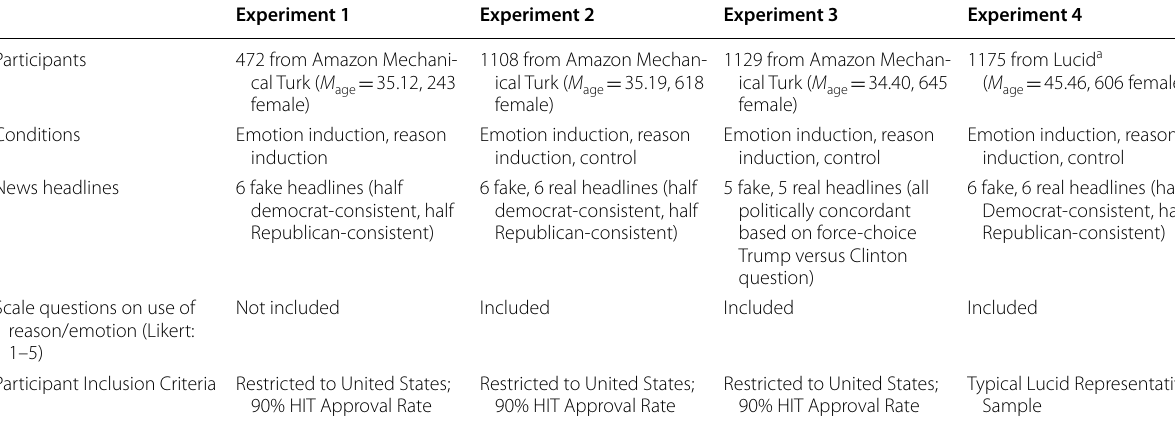
Lucid, an online convenience sampling platform comparable to Mechanical Turk, is purported to have a larger pool of subjects than MTurk, less professionalized subjects, and subjects more similar to US benchmarks regarding demographic, political, and psychological profiles (see Coppock and McClellan